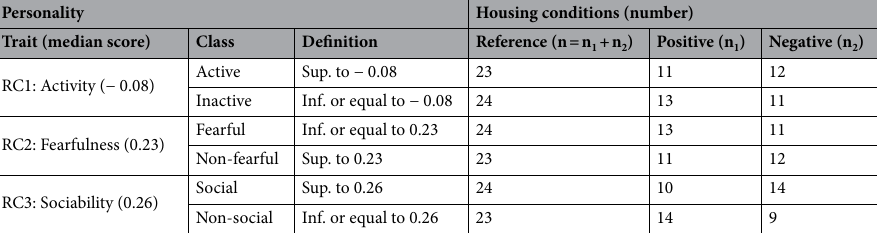
Table 2. Number of heifers in each housing conditions per personality trait. Heifers were divided in two classes per personality trait based on their behavioural scores on the related personality trait in comparison to the median score. Sup . Superior to, Inf. Inferior to, RC rotated component, n number of heifers per personality class in the reference conditions, n 1 number of heifers per personality class in the positive conditions, n 2 number of heifers per personality class in the negative conditions.